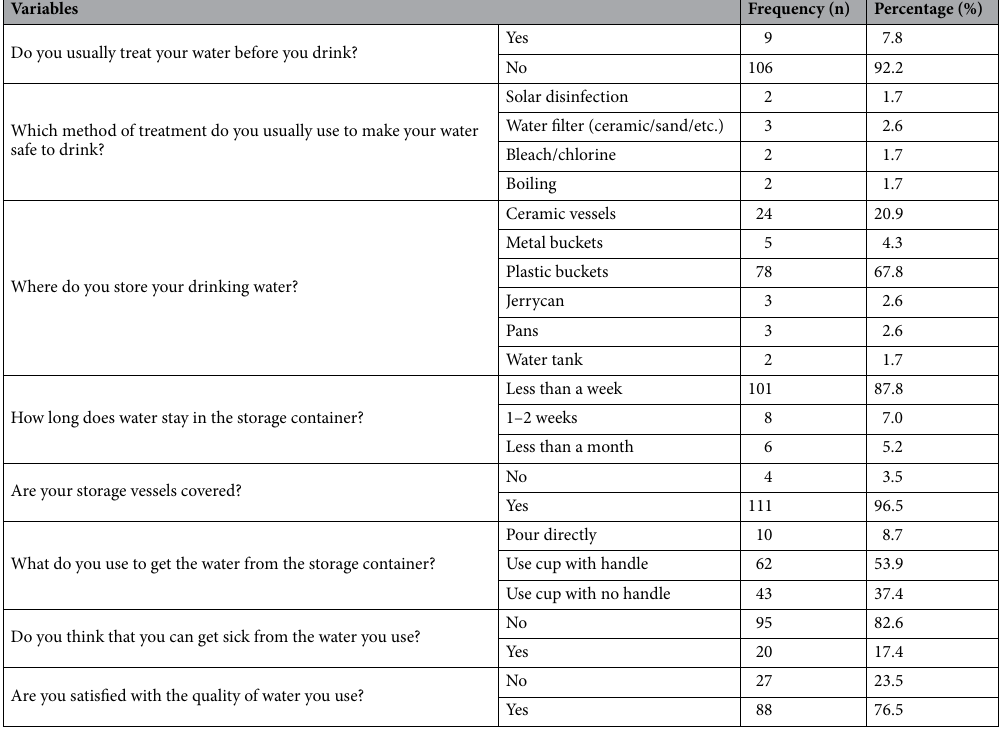
Table 3. Water storage and treatment practices at the